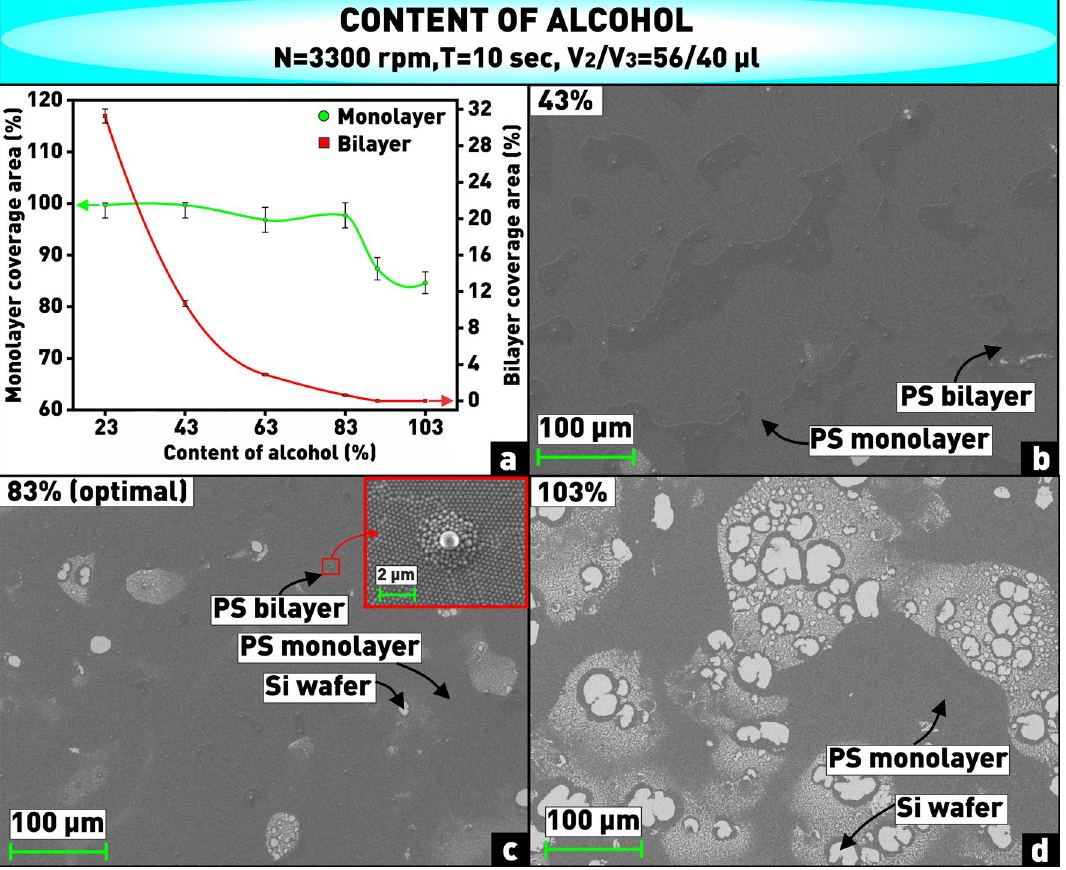
Figure 5. (a) Plot of dependence of substrate coverage area by monolayer and bilayer of PS nanospheres on content of isopropyl in solution; (b–d) microphotographs of nanosphere coatings obtained at varying content of isopropyl in